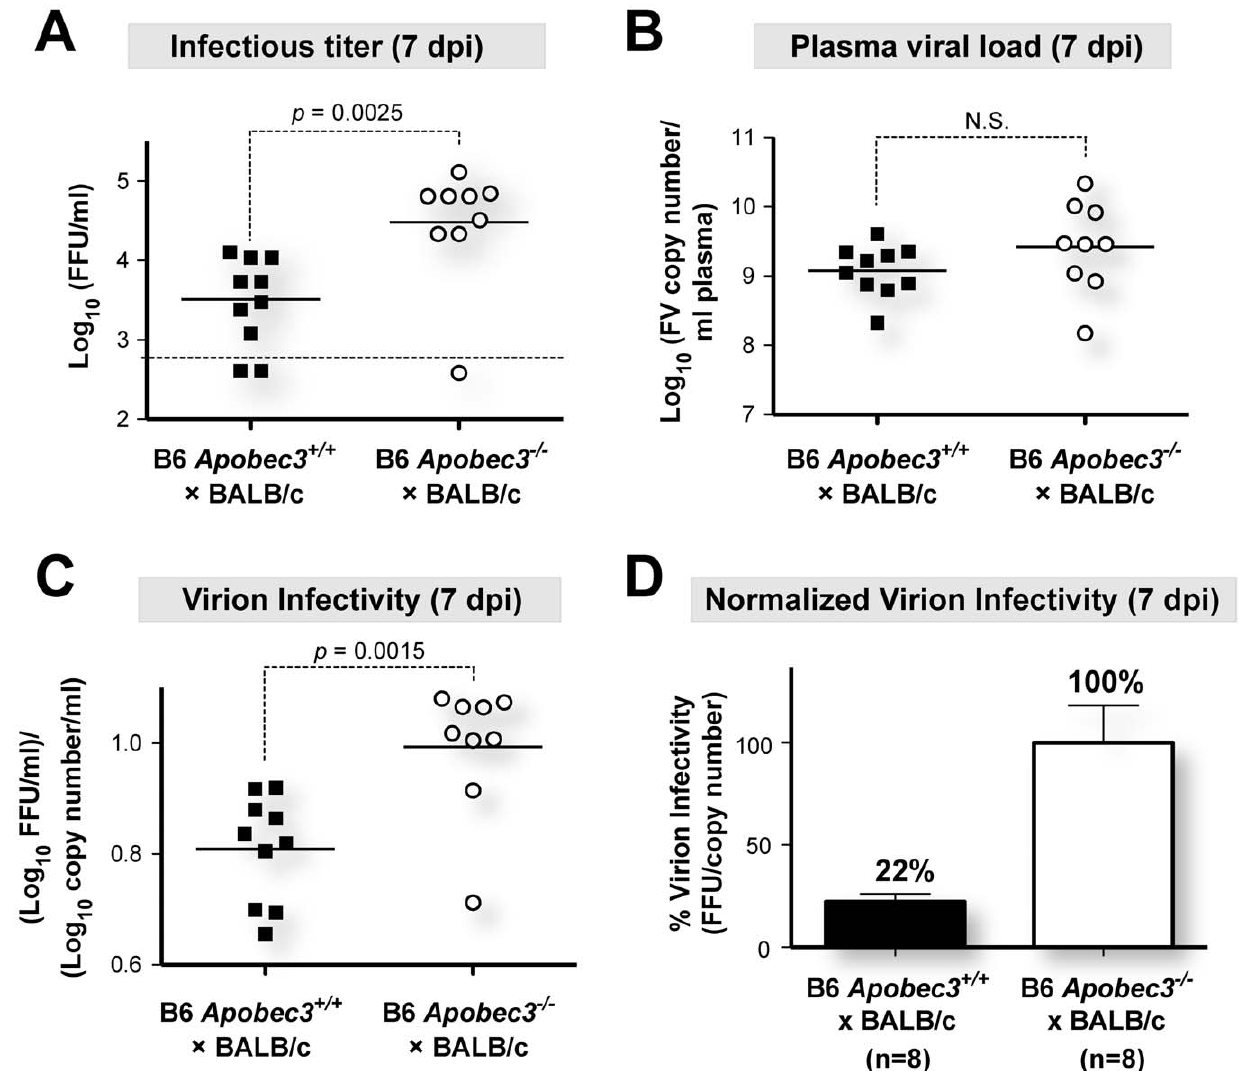
Figure 1. B6 mA3 promotes noninfectious particle release during acute FV infection. (B6 6 BALB/c)F 1 mice were infected with 140 SFFU of FV complex and 7 dpi plasma samples from B6 mA3 + and B6 mA3 2 F 1 mice were subjected to infectious viremia titration in Mus dunni cells and viral RNA copy determinations by quantitative PCR. Virion infectivity for each sample was measured by taking the ratio of infectious titer and viral load. (A) Infectious viremia and (B) plasma viral load during acute infection of (B6 6 BALB/c)F 1 mice are shown as log 10 values. (C) Virion infectivity was calculated by taking the ratio of log 10 infectious titer and plasma viral load. (D) Virion infectivity was also compared with non-log transformed values, setting the average infectious titer per viral copy number of (B6 mA3 2 / 2 6 BALB/c)F 1 as 100%. Samples below the assay limit of detection (below the dotted lines in panel A) were excluded in this calculation. Solid lines correspond to mean values, and p values from a two-tailed Student’s t test are shown. Each dot corresponds to an infected mouse. Error bars correspond to the standard error of the mean.